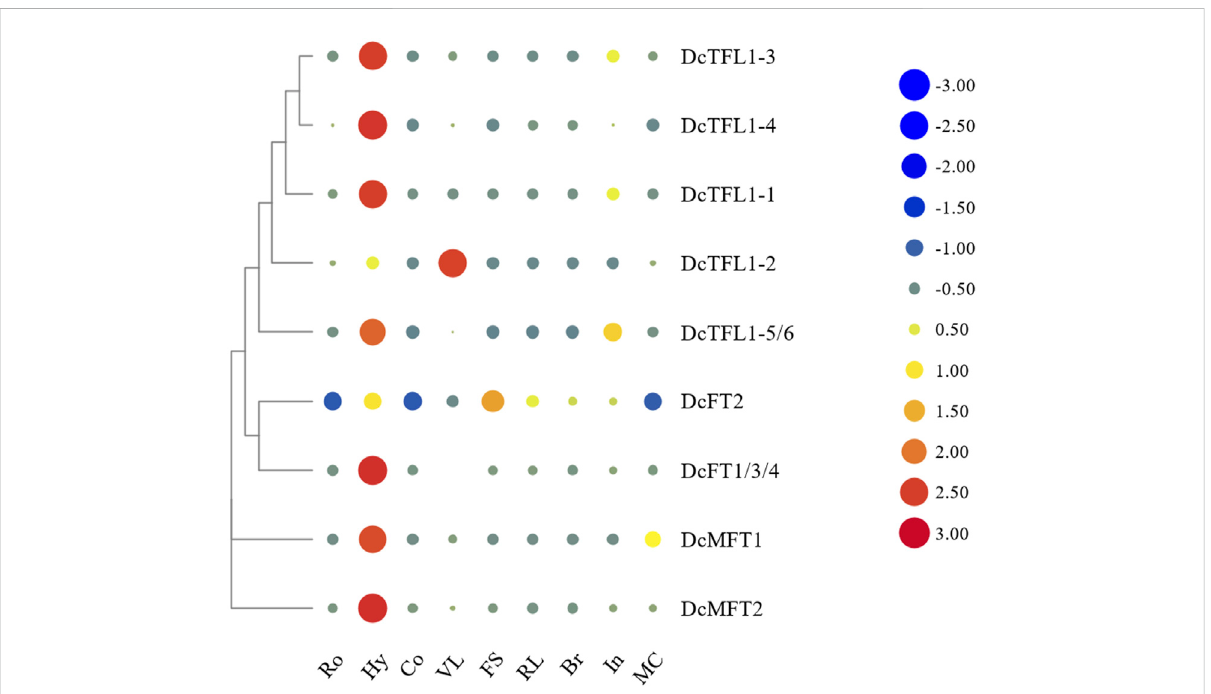
FIGURE 5 Heatmaprepresentationofcarrot PEBP geneexpressionlevelsinvarioustissues.Ro:root,Hy:hypocotyl,Co.cotyledon,VL:vegetativeleaf,FS: fl ower stem, RL: reproductive leaf, Br: bract, In: in fl orescence, MC: mature cremocarp. The color scale with red and blue represent high and low values, respectively; color scale from – 3.0 to